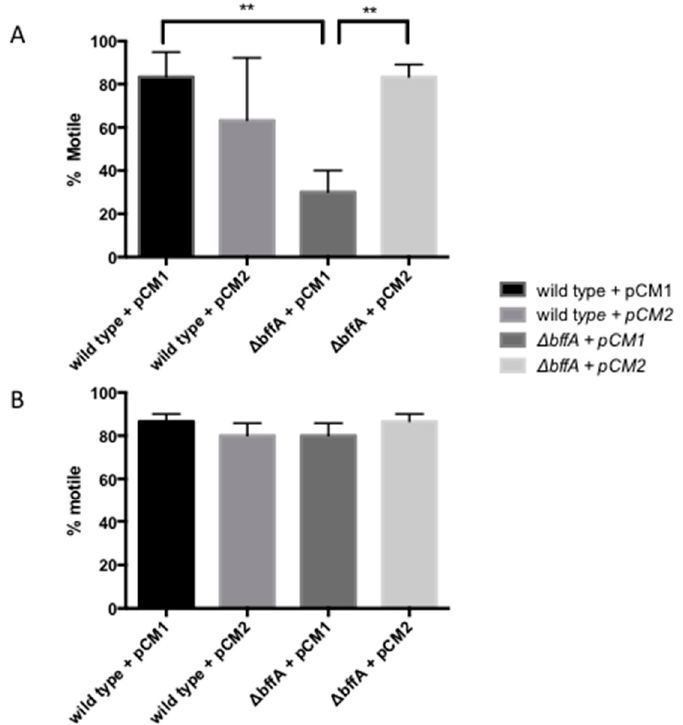
Figure 4. ∆ bffA has reduced flagellar motility at 37 ◦ C, but not 30 ◦ C . Flagellar motility assays per- formed at 37 ◦ C with the JR32 strains ( A ) and 30 ◦ C ( B ) as detailed in the materials and methods. Figure 4. Δ bffA has reduced flagellar motility at 37 °C, but not 30 °C. Flagellar motility assays performed ** p < 0.005, N = at 37 °C with the JR32 strains ( A ) and 30 °C ( B ) as detailed in the materials and methods. ** p < 0.005, N = 3.